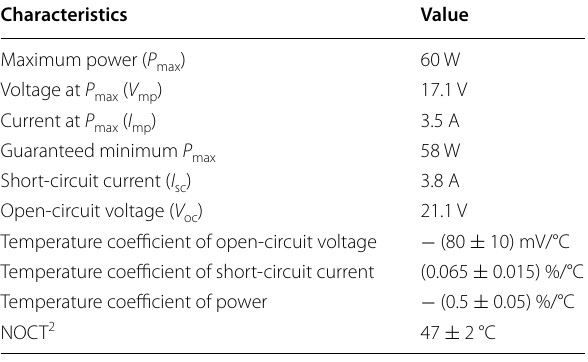
Table 1 Characteristics of the MSX-60 PV panel